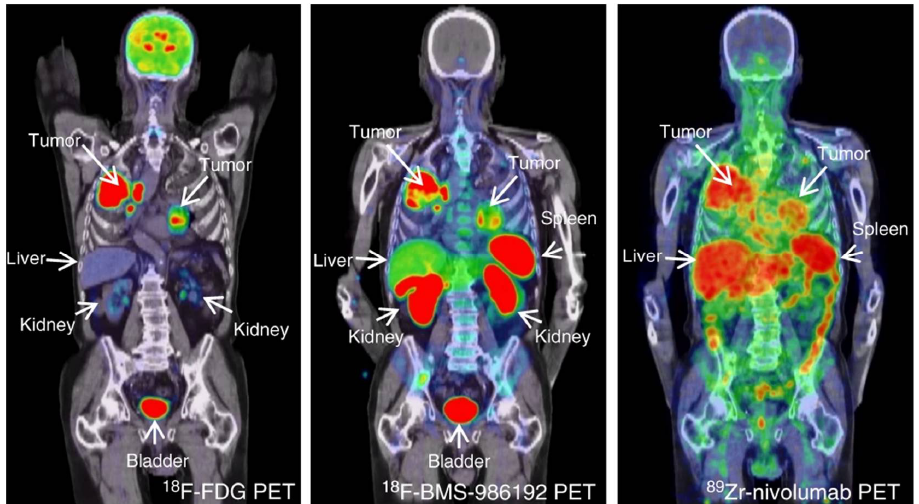
Figure 12. PET imaging of a patient with non-small-cell lung cancer [18]. ( Left ): Image showing the [ 18 F]FDG PET scan, which shows the high glucose metabolism of tumors in both lungs and mediastinal lymph nodes. ( Middle ): [ 18 F]F-BMS-986192 PET (145.7 MBq, 1 h post-injection (p.i.)) and ( Right ): 89 Zr-labeled nivolumab PET (37.09 MBq, 162 h p.i.) demonstrate the heterogeneous tracer uptake within and between tumors. The figure is reproduced with permission from [18].